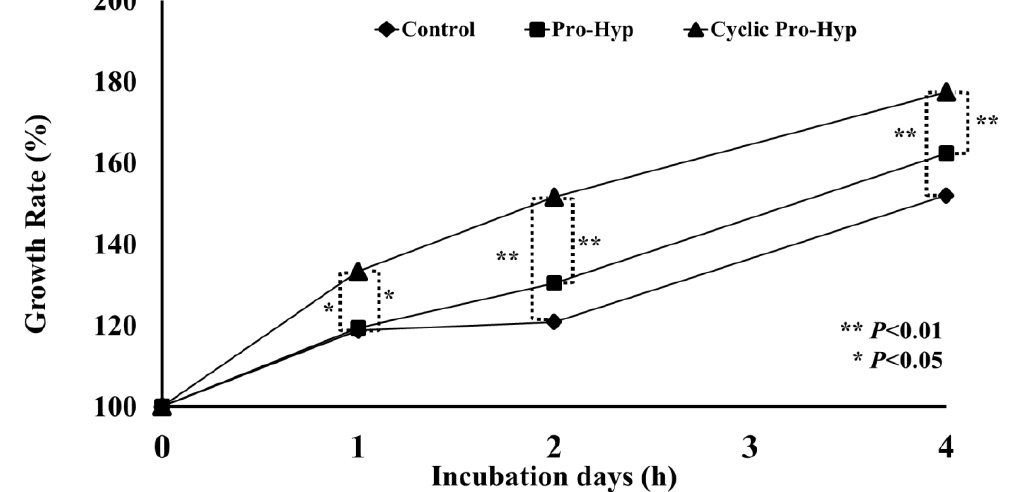
Figure 7. Growth rates of mouse skin fibroblasts on collagen gel. Growth rates were estimated after 0, 1, 2, and 4 days of incubation in the presence of linear ( ■ ) and cyclic ( ▲ ) Pro-Hyp or in the absence ( ● ) of both peptides. ** and * indicate significant differences ( P < 0.01 and P < 0.05, respectively).